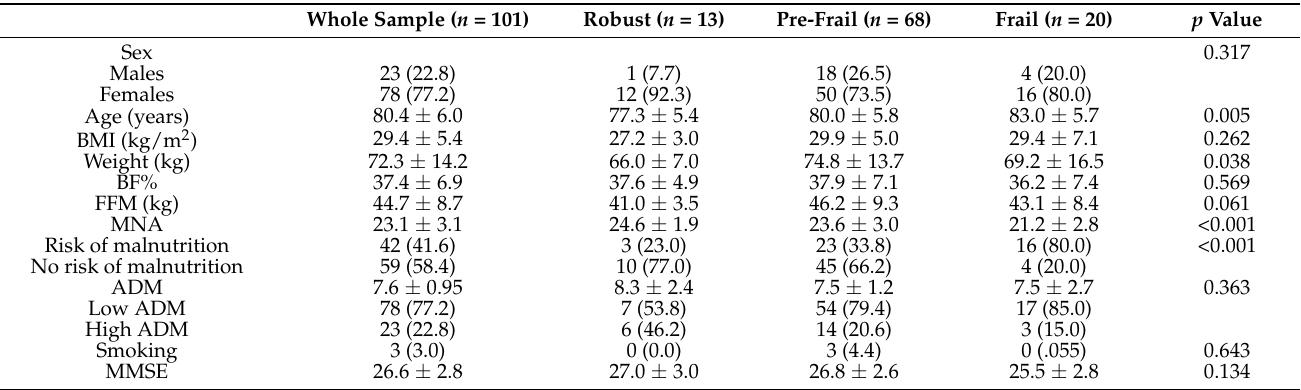
Table 1. Descriptive characteristics of the participants of the study.